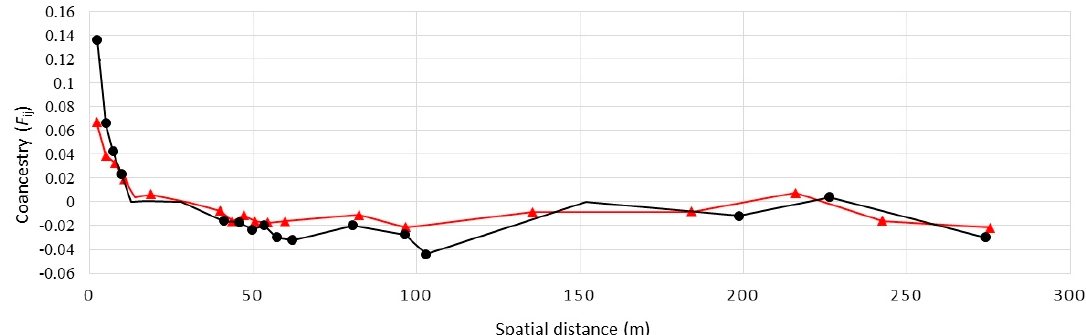
Figure 4. Analysis of the clonal structure of the S. brachyodon population by means of a spatial autocorrelation analysis of co-ancestry ( F ij ). Genet-level (in red) and ramet-level (in black) analyses were performed. Significant ( p < 0.05) F ij values for a given distance class are marked with red triangles and black circles (for the genet- and ramet-level analysis, respectively).